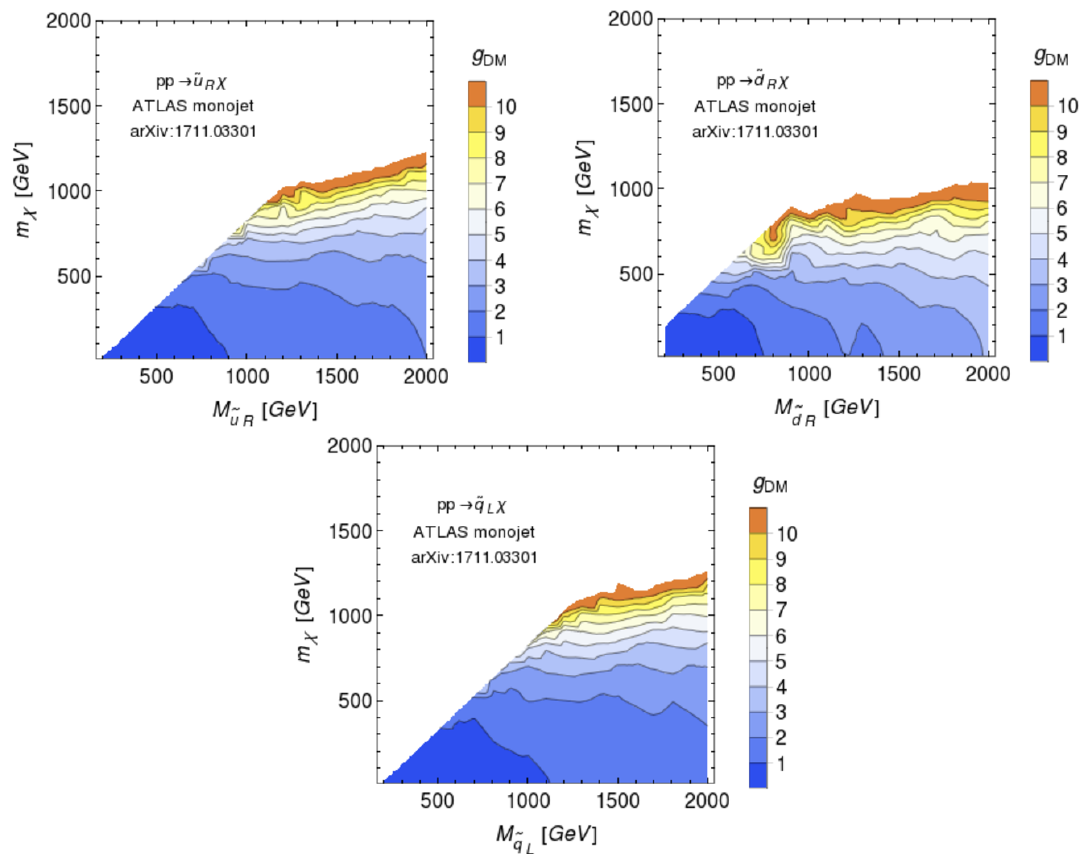
Figure 11 . ATLAS mono-jet constraints on g DM derived from associated production for the u R (upper left), d R (upper right) and q L (lower) models. Despite the moniker \mono-jet", this